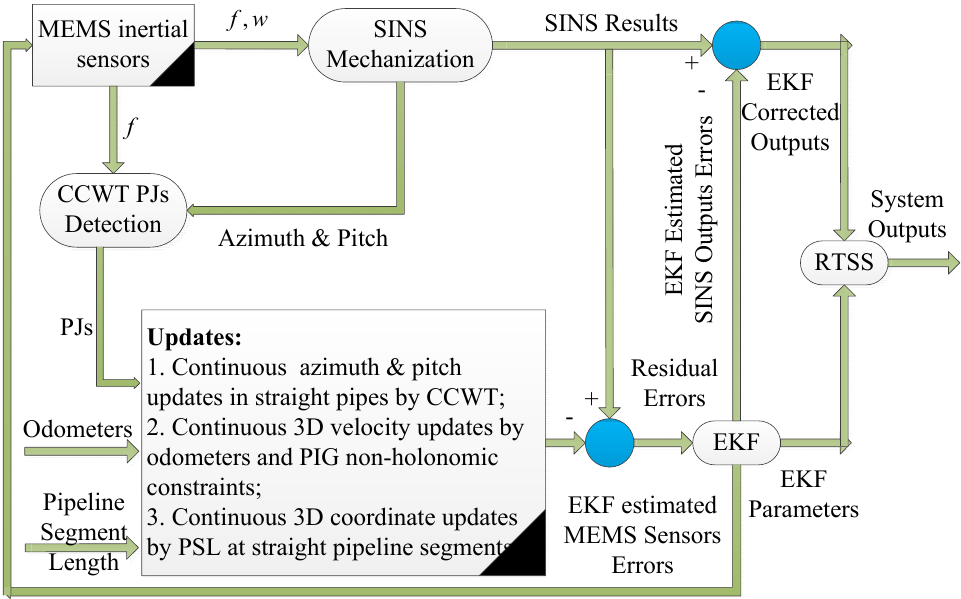
Figure 9. Schematic of SINS / Odo / PJ / Pipeline Segment Length (PSL)-based intelligent PIG surveying technology.